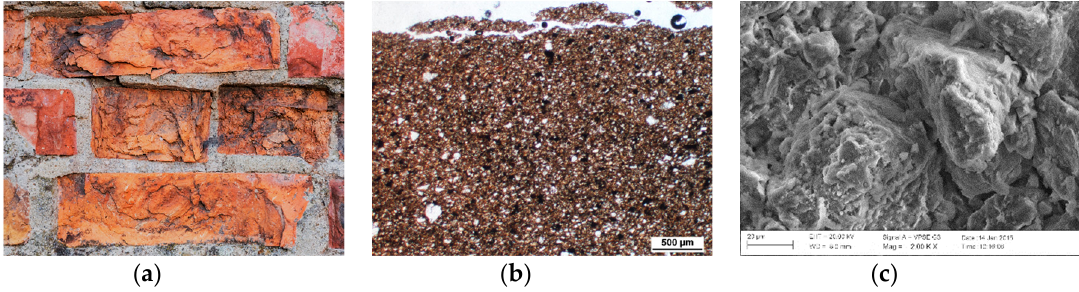
Figure 4. Macroscopic view of damage of the surface of the bricks as a result of surface flaking on the inside of the sprinkler ( a ). Optical microscope image in transmitted light. Crevice pattern matching the arrangement of the ceramic mass layers ( b ). Microstructure of bricks damaged as a result of surface flaking ( c ).